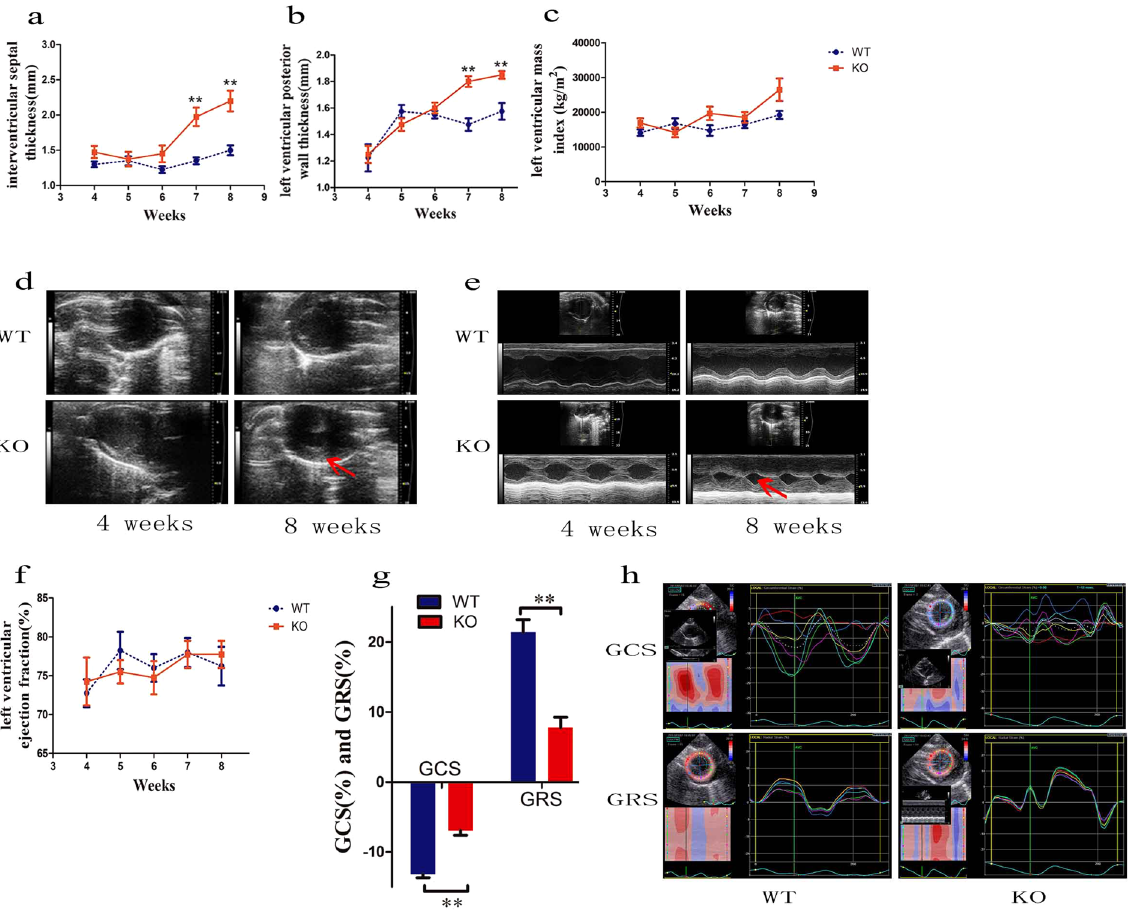
Figure 1. Echocardiographic parameters and representative echocardiographic images of Lamp2 y/ − rats and wild-type rats. ( a ) IVSd; ( b ) LVPWd; ( c ) LVMI; ( d ) Echocardiographic image of left ventricular wall and dimensions; ( e ) Echocardiographic images of left ventricular systolic function; ( f ) LVEF; ( g ) GCS, GRS; ( h ) Echocardiographic images of GCS and GRS. Mean ± SEM, n = 10 rats per group. * P < 0.05; ** P < 0.01. WT, wild-type male rats; KO, Lamp2 y/ −